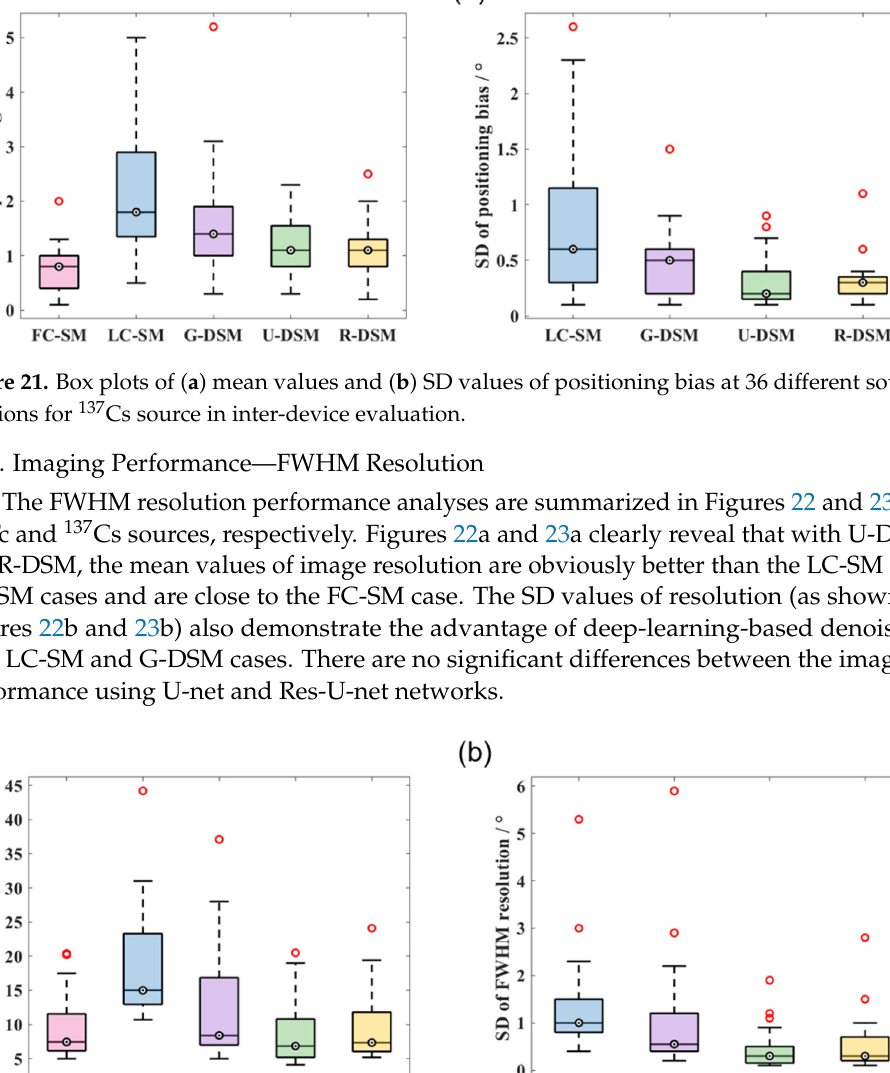
Figure 20. Box plots of ( a ) mean values and ( b ) SD values of positioning bias at 36 different source positions for 99m Tc source in inter-device evaluation.